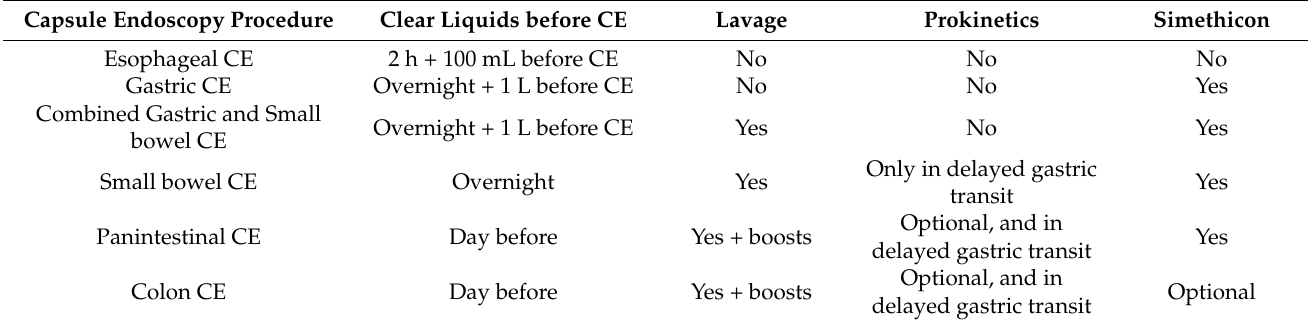
Table 2. Simplified recommendations for different capsule endoscopy